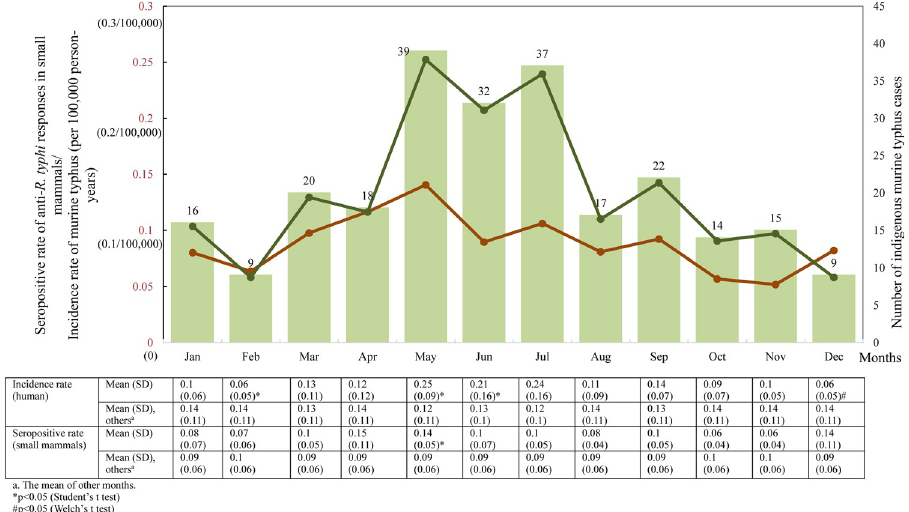
Fig 4. Monthly seropositive rate of anti- R . typhi responses in small mammals and incidence rate of indigenous murine typhus in humans from 2007–2014. The seropositive rate and incidence rate (per 100,000 person-years) are shown as brown and green curves, respectively. The numbers of indigenous murine typhus cases are shown as green bars. The correlation between the incidence rate of indigenous human cases/seropositive rates in small mammals and months is presented in the table